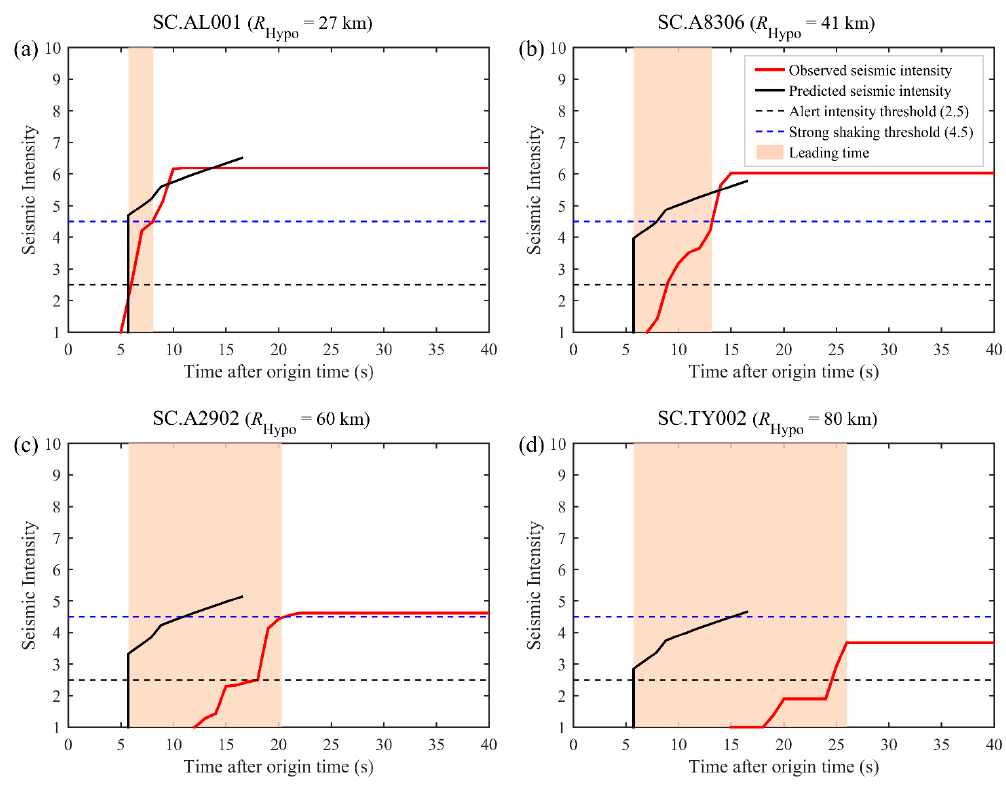
Figure 5. Predicted and observed SIs computed during the 2022 M 6.1 Lushan event for example sites S.AL001, SC.A8306, SC.A2902, and SC.TY002 with hypocentral distances of ( a ) 27 km, ( b ) 41 km, ( c ) 60 km, and ( d ) 80 km, respectively. The L1DM predicts SIs above the alerting intensity threshold of SI alert = 2.5 for all sites immediately after the initial warning message at 5.7 s after the earthquake occurrence. The leading times are measured relative to either strong shaking threshold SI tw = 4.5 or the arrival time of the S -wave (if SI tw = 4.5 is not reached). Two time terms need to be defined for their use in leading time calculations. One is